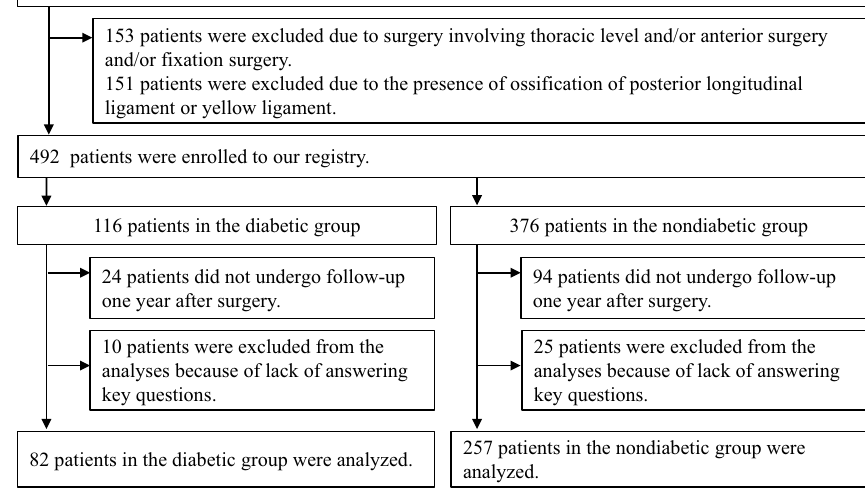
Figure 1. Flowchart of the study population.